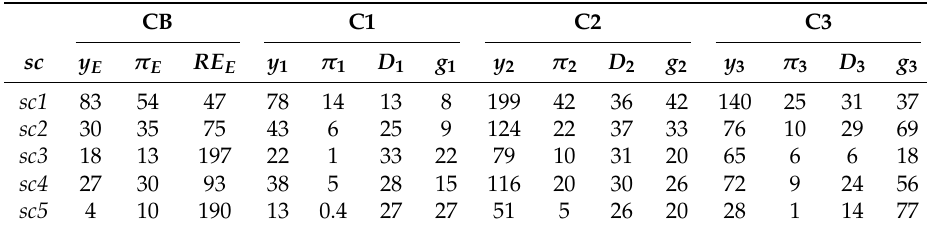
Table 8. Detailed objective function